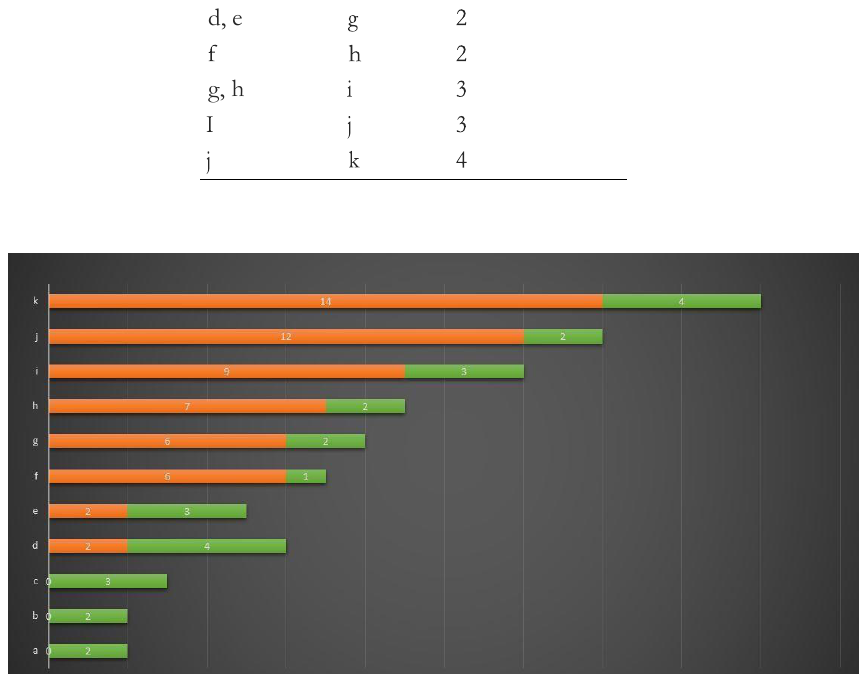
Fig. 3. Gantt chart for total production